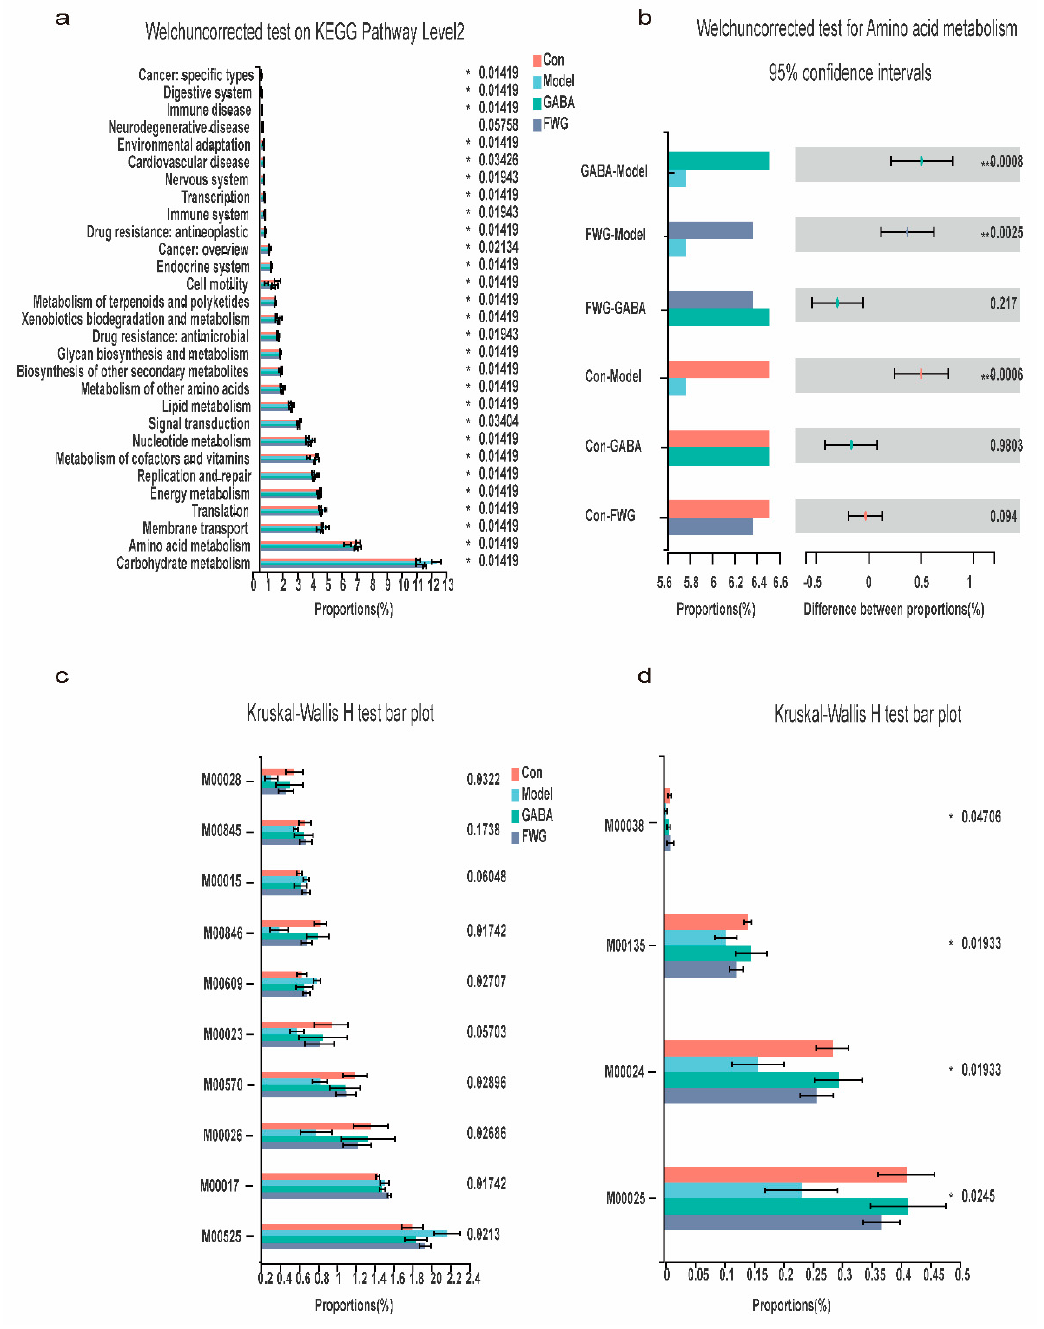
Figure 8. Effect of FWG on fecal microbiota function. ( a ) Differential pathways on KEGG Path Level2 in various groups of rats. ( b ) Wilcoxon rank − sum test of each group of rats in the amino acid metabolic pathway. ( c , d ) Differences between groups of rats related to the function of amino acid metabolism Module. (* p < 0.05, ** p < 0.01, *** p < 0.001 indicates a statistically significant difference.) Table 2. Annotation of Modules related to amino acid metabolism.